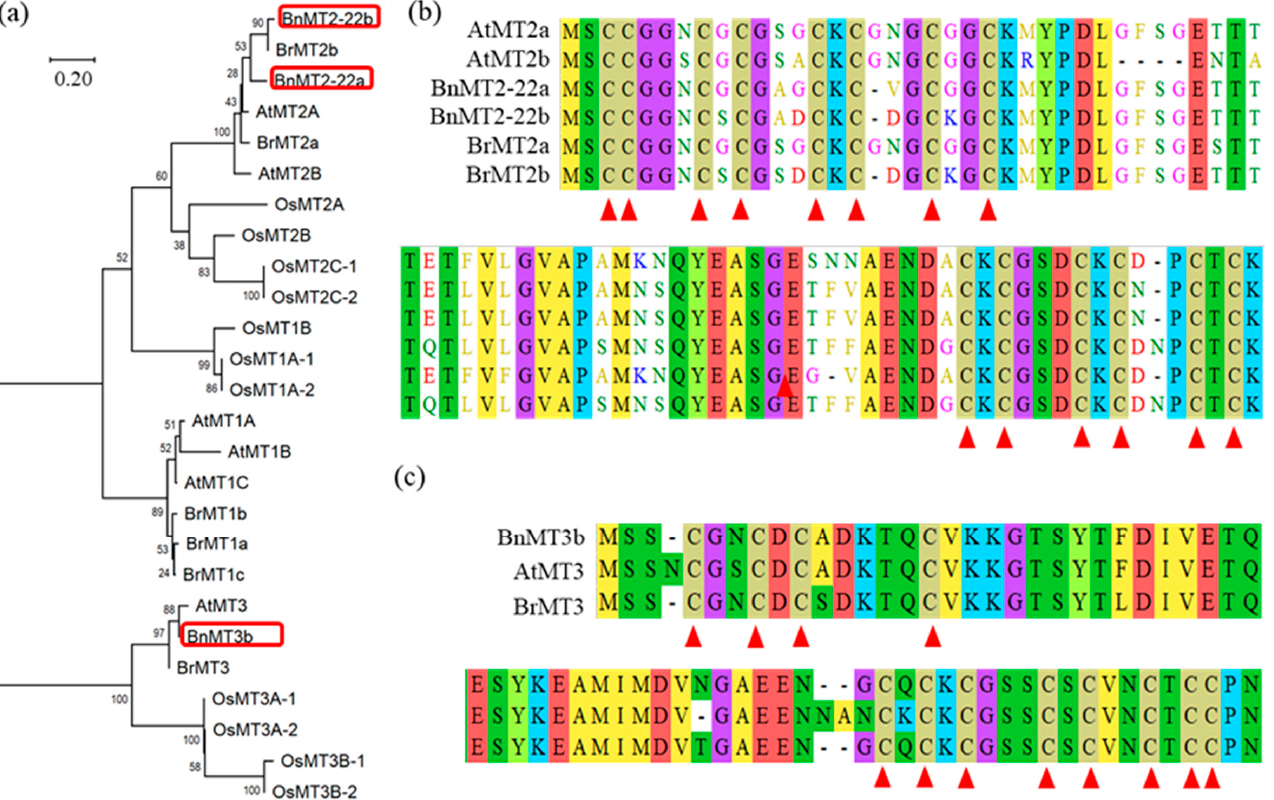
Figure 1. Sequence analysis of BnMTs. ( a ) Phylogenetic tree analysis of BnMTs with metallothi- onein family from Arabidopsis thaliana (At), Rice (Os) and Brassica rapa (Br). ( b , c ) Sequence align- ment of BnMT2-22a, BnMT2-22b (B)and BnMT3b (C)with their homologues of Arabidopsis thaliana and Brassica rapa